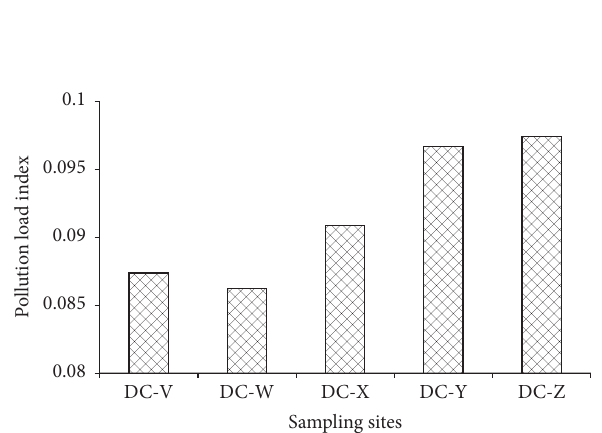
Figure 3:Pollution load index of metals atsampling sites of Douglas